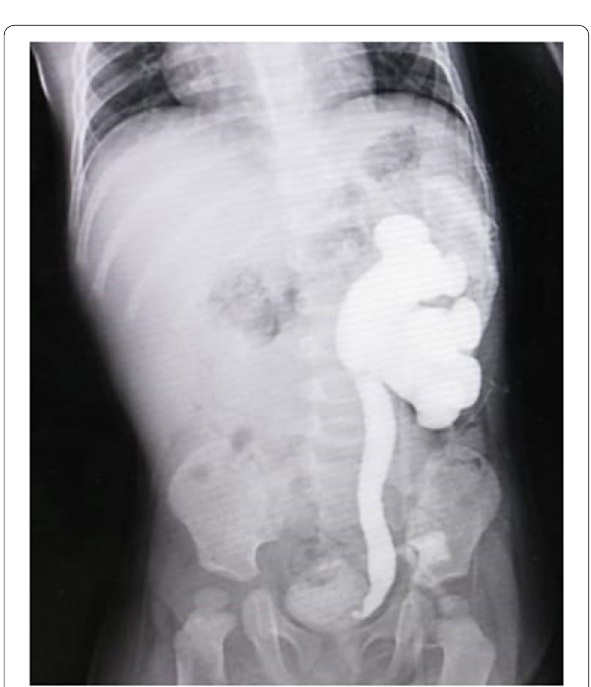
Fig. 4 Nephrostogram showing free passage of the contrast through UPJ after LP; however, there is arrest of the contrast at uretro‑vesical junction indicating the presence of concomitant distal obstructive